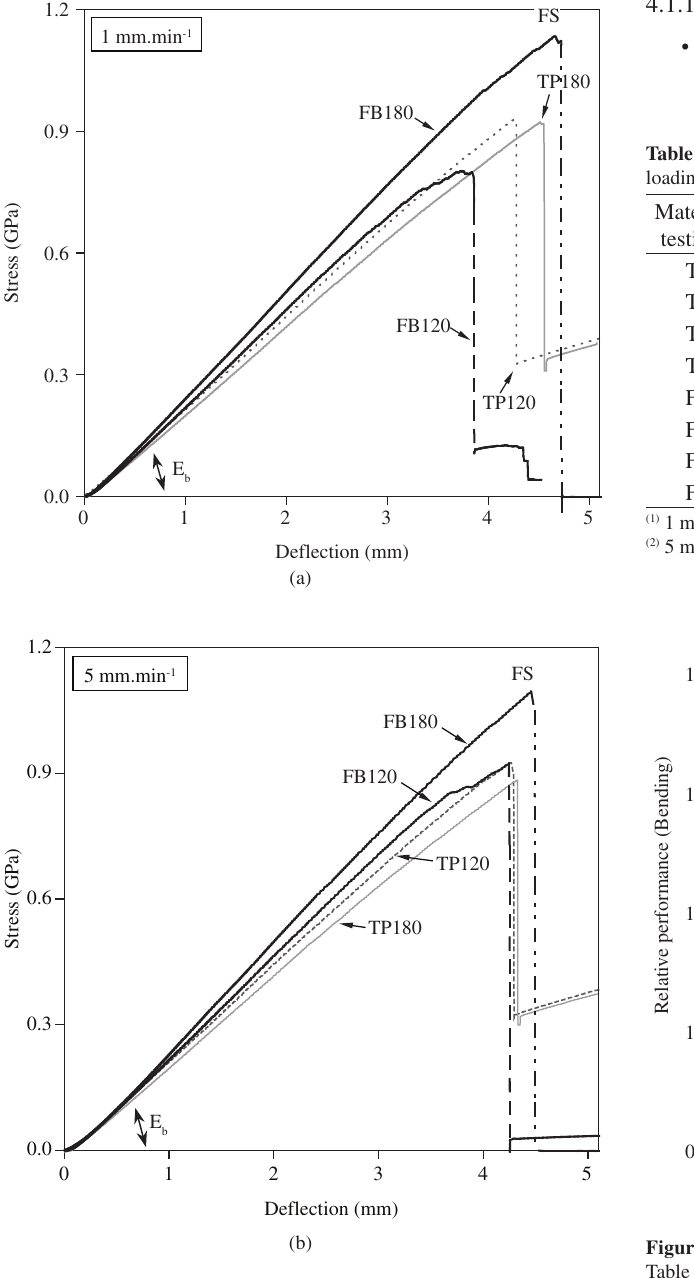
Figure 3. Typical stress-deflection curves for two applied loading rates: a) 1 mm/min; and b) 5 mm/min.